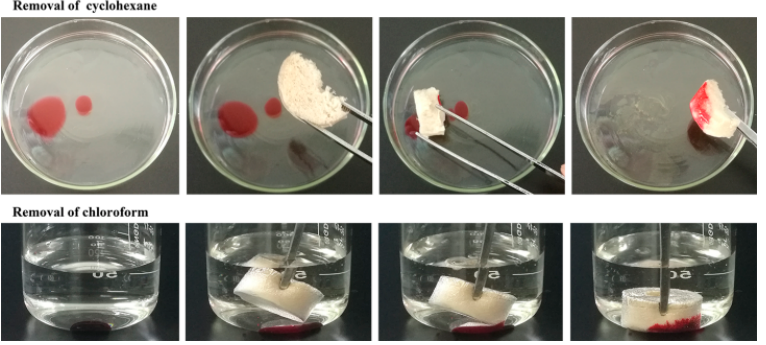
Figure 6 . Adsorption of red-colored cyclohexane and chloroform from the surface and bottom of water using the Si-CNF/BTCA.